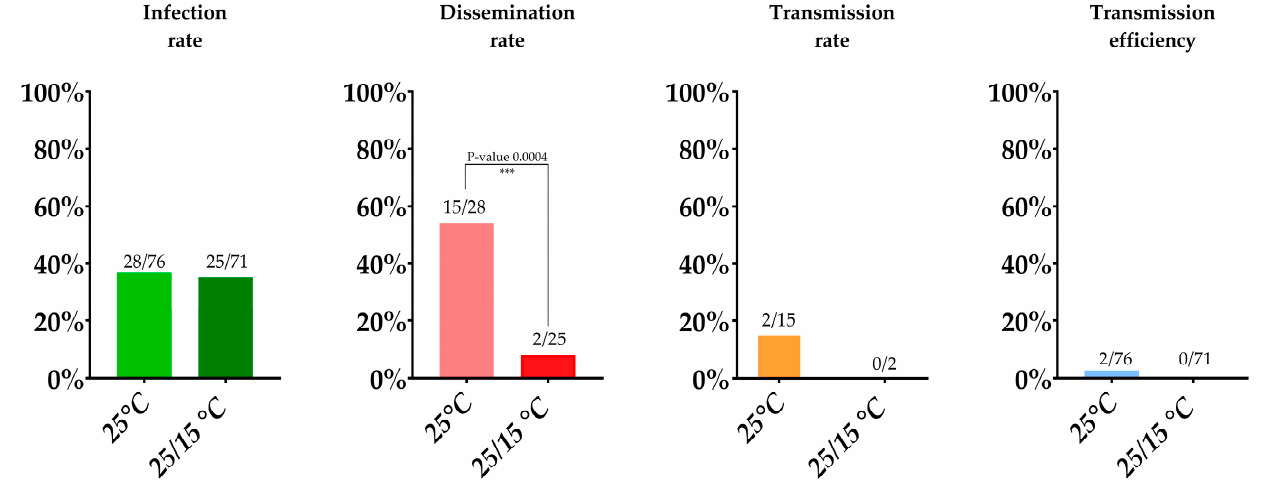
Figure 2. Infection rate, dissemination rate, transmission rate, and transmission efficiency at the two temperature conditions. Absolute numbers are displayed above bars. Fisher’s exact tests were performed to check differences between rates at both temperature conditions.